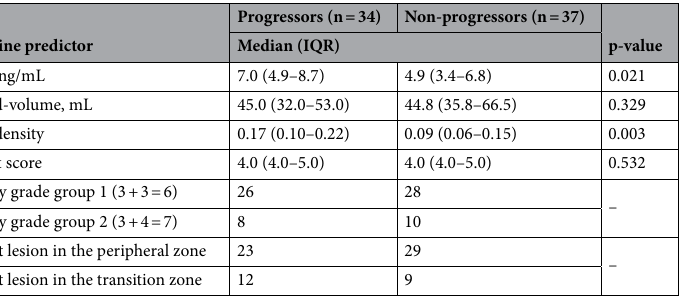
Table 1. Intergroup comparison of standard-of-care baseline clinicopathological predictors of prostate cancer progression in patients enrolled on active